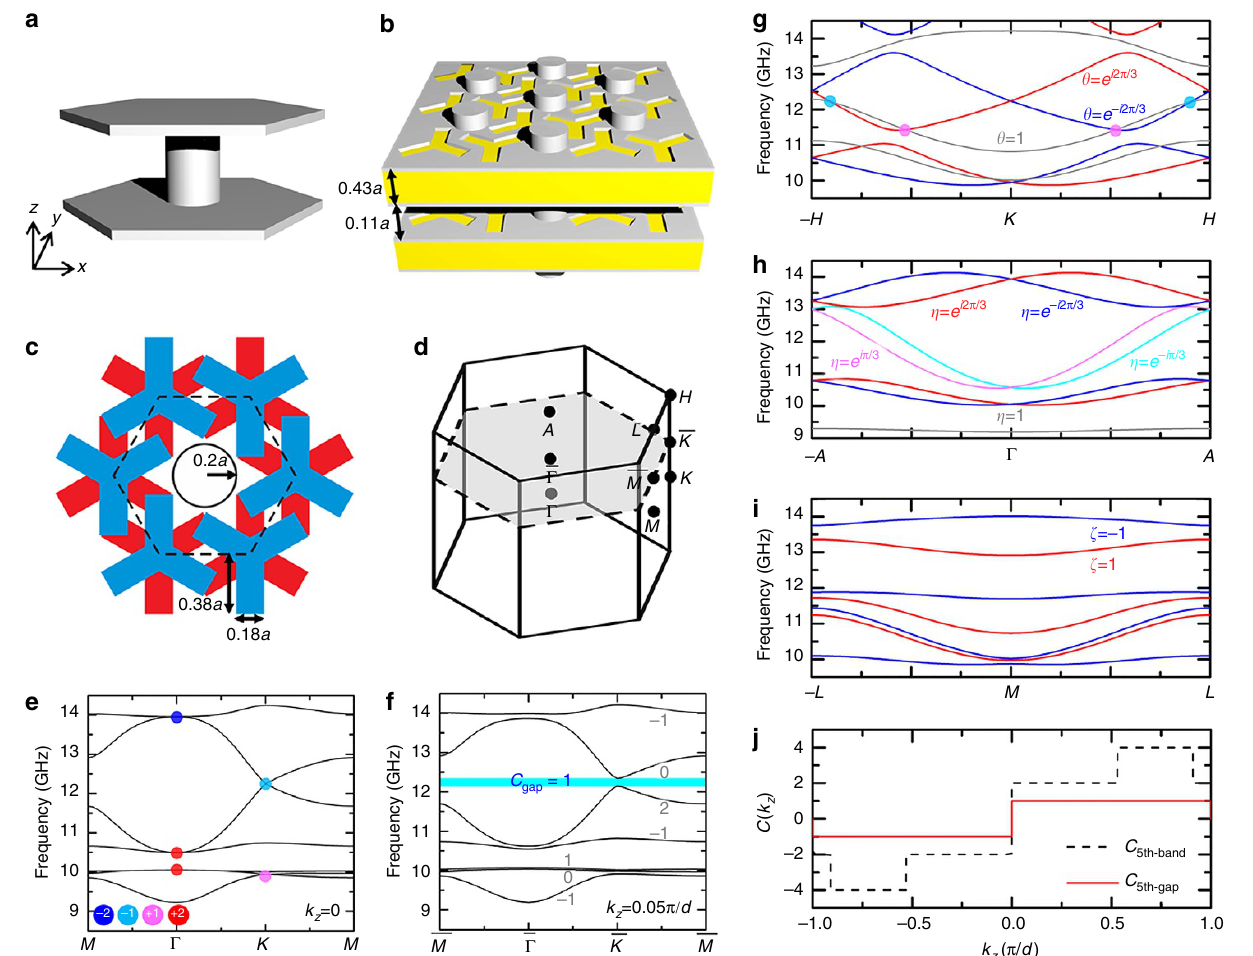
Figure 1 | Realization of Weyl points in an electromagnetic system by introducing interlayer coupling. ( a ) Unit cell of a single-layer system built from a hexagonal array of perfect electric conductor (PEC) cylinders bounded by two PEC slabs. This can be realized with metal-coated PCBs that are pierced through by a hexagonal array of aluminium rods. PCBs stacked in the z direction form a 3D photonic crystal. ( b ) Multilayer system built from PCBs stacked in the z direction. Interlayer couplings are introduced by the Y-shaped slots on two sides of the PCBs. ( c ) Top view of the unit cell (dashed hexagon) of the multilayer system. Blue and red areas highlight the Y-shaped slots on the upper surface and the lower surface of the PCBs. ( d ) Reciprocal space of a hexagonal lattice. Since the photonic crystal has translational symmetry along the z direction, k z is a good quantum number. The system with a fixed k z has a 2D band structure in the reduced Brillouin zone (grey plane in d ). Chern numbers are well defined for each k z slice. Weyl points can be viewed as the phase transition points between the k z slices with different Chern numbers. ( e ) Bulk band structure in the k z ¼ 0 plane. The structure has several Weyl points with different charges (in different colours). ( f ) Bulk band structure in the k z ¼ 0.05 p / d plane. ( g – i ). Dispersion along the z direction at K , G and M , respectively. Bands with different rotational eigenvalues are plotted in different colours. Since a change in rotational eigenvalue results in a change in the band (gap) Chern number, each crossing point in g or h is a Weyl point whose charge depends on the ratio between the rotational eigenvalues of two intersecting bands. Four Weyl points between the 4th and 5th bands, which induce the jumps in the Chern number of the 5th band in j , are highlighted in g . ( j ) Chern numbers of the 5th gap (red solid line) and the 5th band (black dashed line) as a function of k z , the jump in which implies the topological charge of associated Weyl